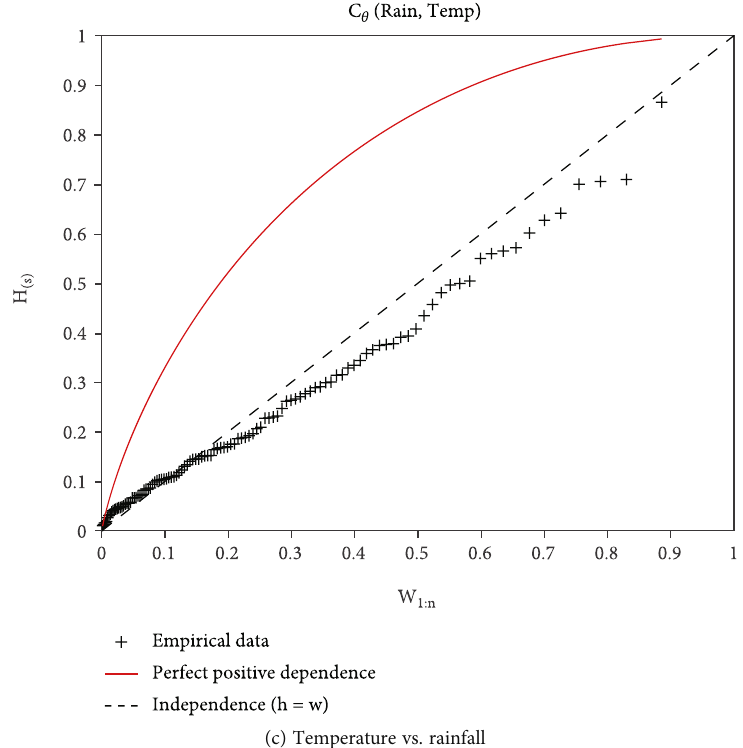
Figure 5: KK − plots for the three